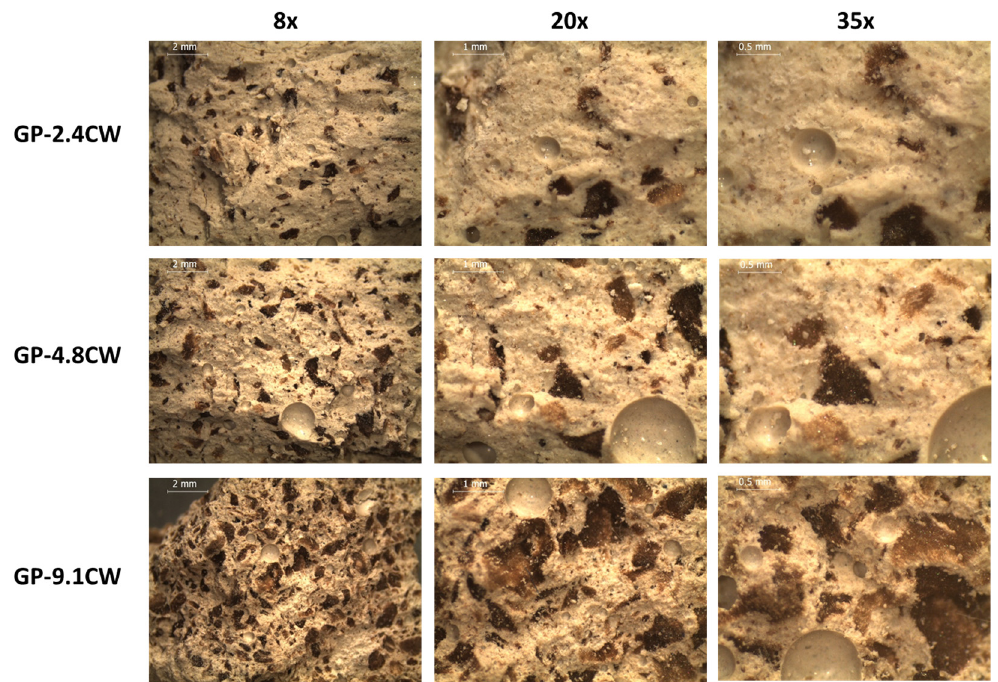
Figure 7. Optical microscopy images of the CW formulations with different magnifications (2, 1 and 0.5 mm bar are reported in each photograph, depending on the enlargement). 0.5 mm bar are reported in each photograph, depending on the